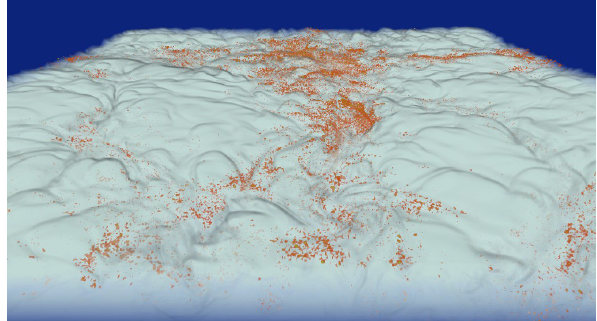
Figure 4. Visualization of the stratocumulus cloud top at t = 11 . 1 t ∗ . The white contours represent the liquid field from the Eule- rian calculations. Red and green colors represent average residence times when extrapolating to the Eulerian grid. Only values larger than 0 . 9 t ∗ convective-eddy times are shown, thus signaling long- resident droplets that have escaped the convective movements. The color scale code goes from red to green, representing mean average residence times from 0 . 9 t ∗ to 2 t ∗ .